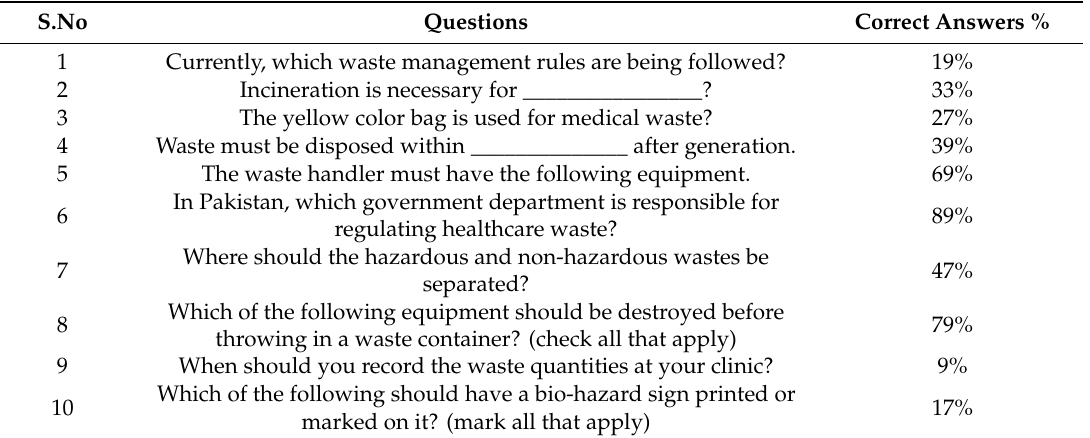
Table 2. Results of the questionnaire